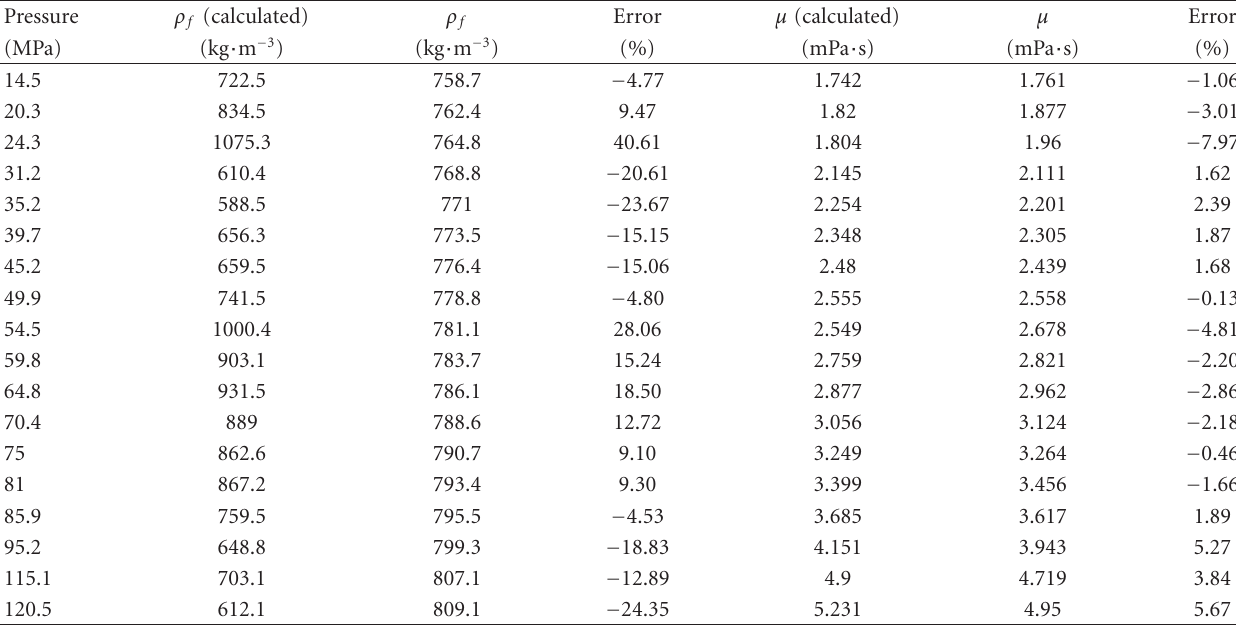
Table 4: Experimental and published viscosity and density data for n-dodecane.